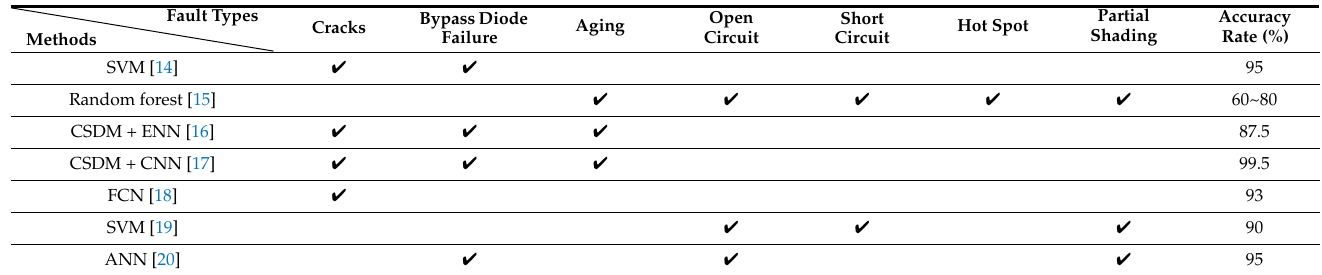
Table 1. Literature review of fault detection method and accuracy rate for PV